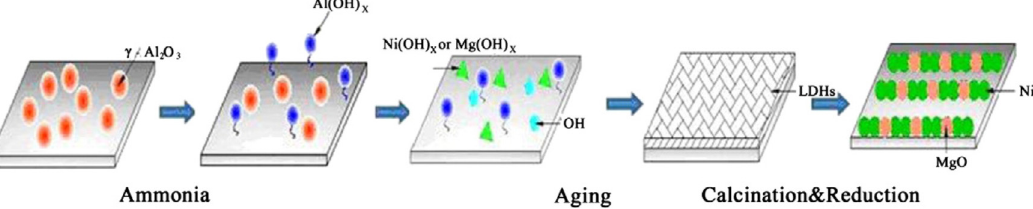
Figure 2. Schematic synthesis process of NiMgAl-HTLcs/ γ -Al 2 O 3 in-situ. Reproduced from [40] with permission of Elsevier. Copyright 2014.